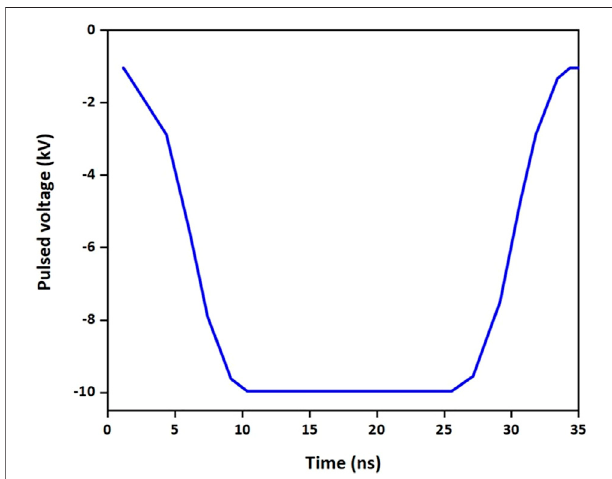
FIGURE 2 | Negative pulsed voltage applied to the electrode.